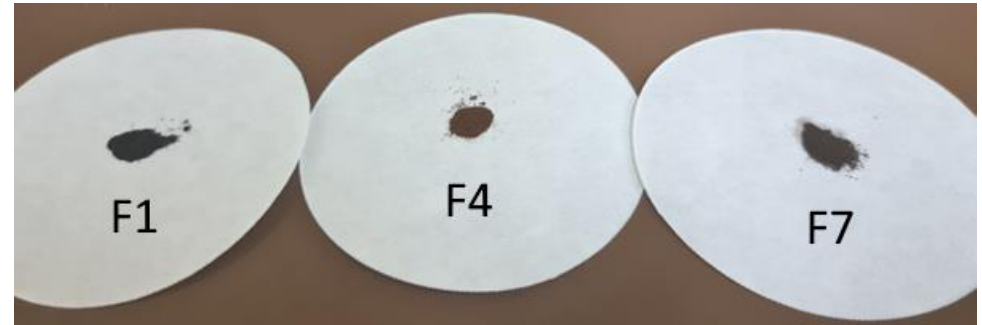
Figure 2. Humins obtained from fructose in different solvents using sulfuric acid as strong Brönsted acid.